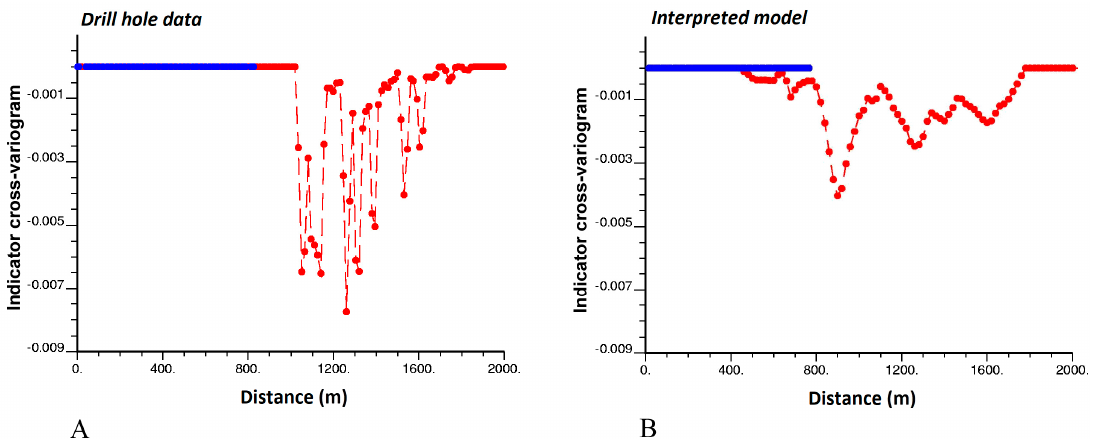
Figure 10. Indicator cross-variogram between rock types 4 (granodioritic porphyry) and 6